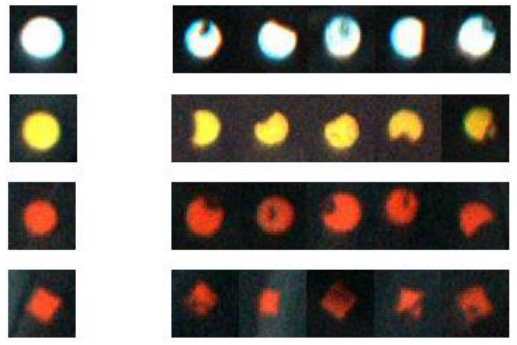
Figure 2. Comparisons of complete and incomplete tire marking points.